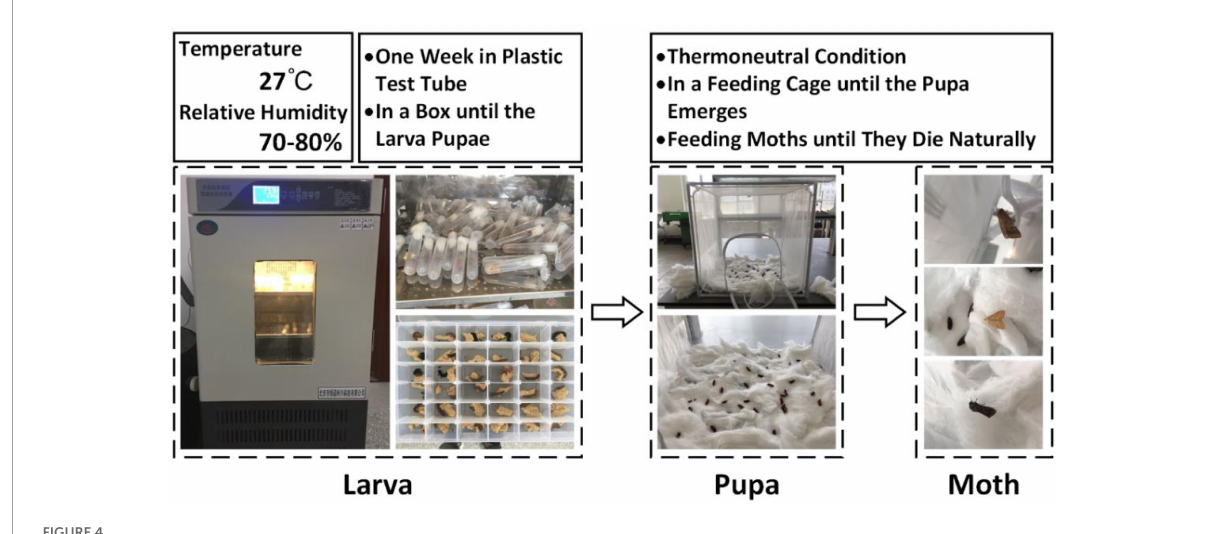
FIGURE4 Insect rearing